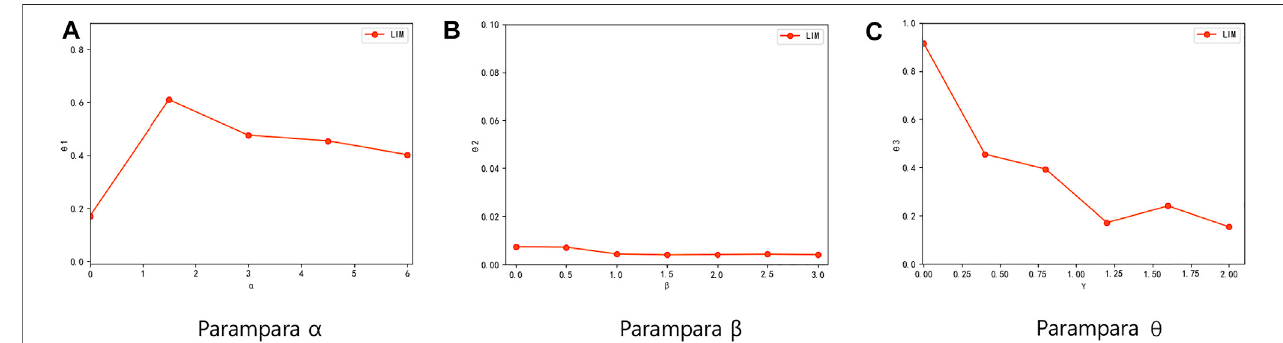
FIGURE7| Results ofparameter testing. Theexperiment iscarried outonSlashdot. The fi rstandthirdexperiments useWCmodels andselect30seeds,while the second one is done under the UN model which set the diffusion probability to 0.5 and selects 100 seeds. The center node of the target nodes is set to node 2,921. (A) Results of parameter α . θ 1 means the proportion of positively activated target nodes among all activated nodes. Each point in this fi gure represents the θ 1 value with a different α value. (B) Results of parameter β . θ 2 means the proportion of negatively activated target nodes among all activated nodes. Each point in this fi gure represents the θ 2 value with different β value. (C) Results of parameter γ . θ 3 means the proportion of positively and negative activated non-target nodes among all activated nodes. Each point in this fi gure represents the θ 3 value with different γ value.